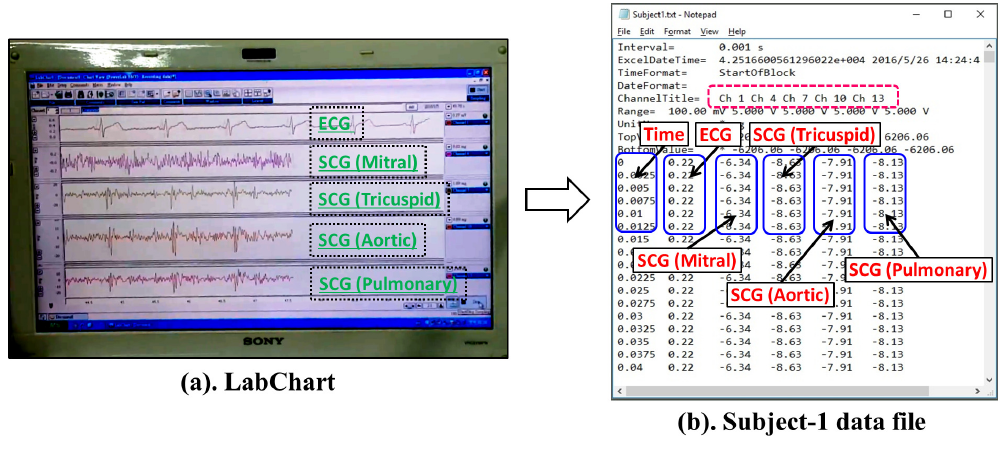
Figure 13. Output of data acquisition module.